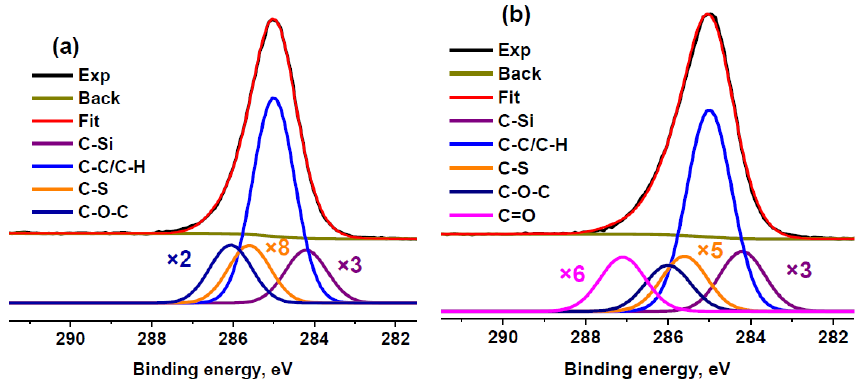
Figure 4. XPS C 1s spectra of RC 0-1a ( a ) and RC 3-5c ( b ) fitted with the extra component attributed to C–S bonds.